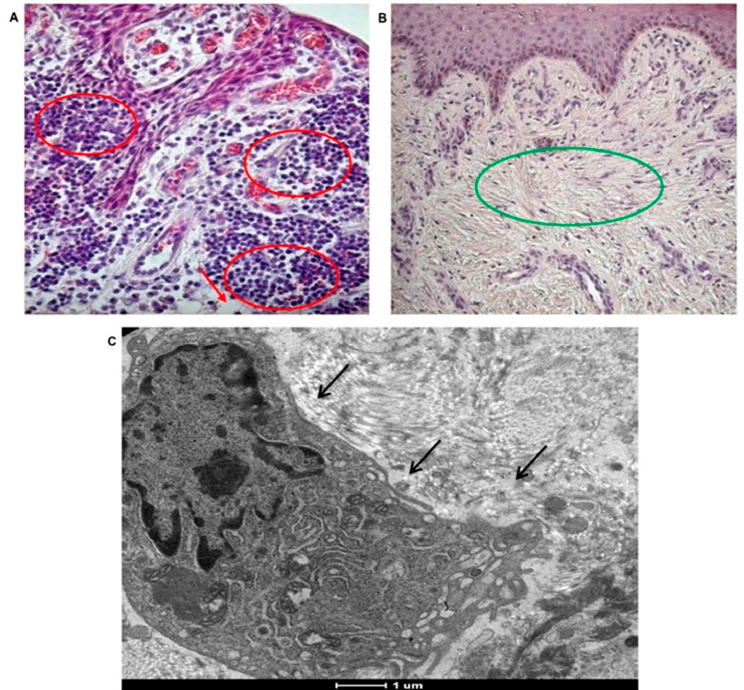
Figure 5. Morphological analyses of tissue affected by peri-implantitis. Presence of inflammation in tissues affected by peri-implantitis. ( A ) Histological staining of polymorphonuclear cells, mostly neutrophils, phagocytic cells (red circle) in tissues affected by peri-implantitis. Collagen fibers are not well represented. Adipose-like tissue (red arrows) is present (20 × magnification). ( B ) Histological staining of healthy tissue showing no inflammatory event and well-organized collagen fibers (green circle). No adipose-like tissue is observable (10 × magnification). ( C ) TEM imagine of extravasated macrophage, (black arrow) in tissues affected by peri-implantitis.